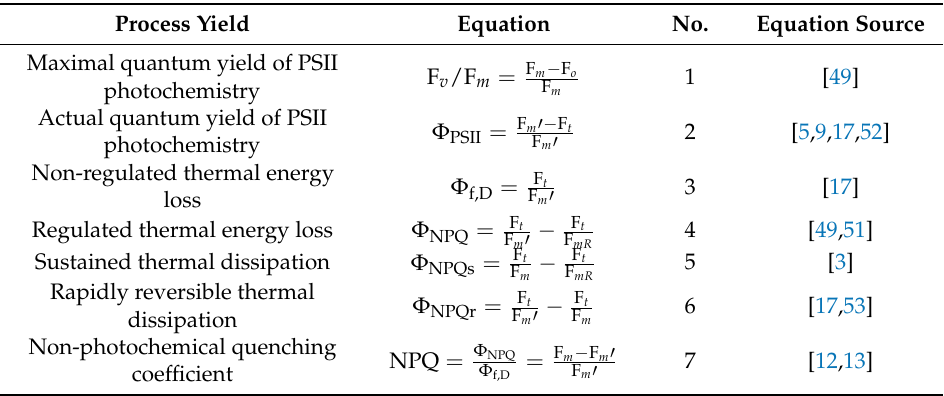
Table 1. Process yields and ChlF-associated yield